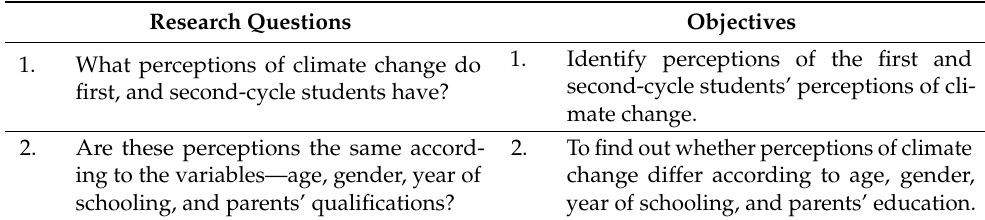
Table 2. Research questions and research objectives.